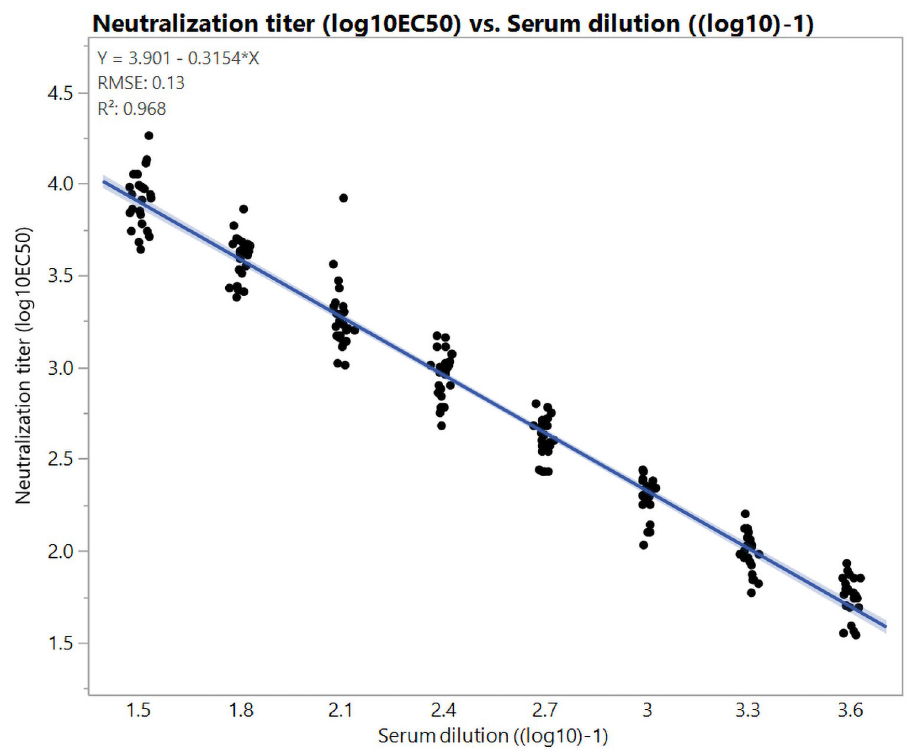
Fig 4. Relationship between serum dilution in assay media and neutralization activity. To examine dilutional linearity in assay media, serum samples were prediluted, starting at 1:8 followed by 2-fold dilutions to generate eight dilutions of samples. The log 10 EC 50 titers were determined by the RLU signal plotted against the log 10 -transformed serum dilution factor and then fitted with a non-linear regression curve with the lower asymptote constrained to 0 using GraphPad PRISM using RLU’s and lower asymptote constrained to 0. The log 10 EC 50 values from each dilution were determined and plotted against the input dilutions (log 10 ) of the serum. Shown is the best fit line and 95% confidence interval (CI) (y = 3.901–0.3154x, with root mean square error = 0.13, and R 2 = 0.968 using